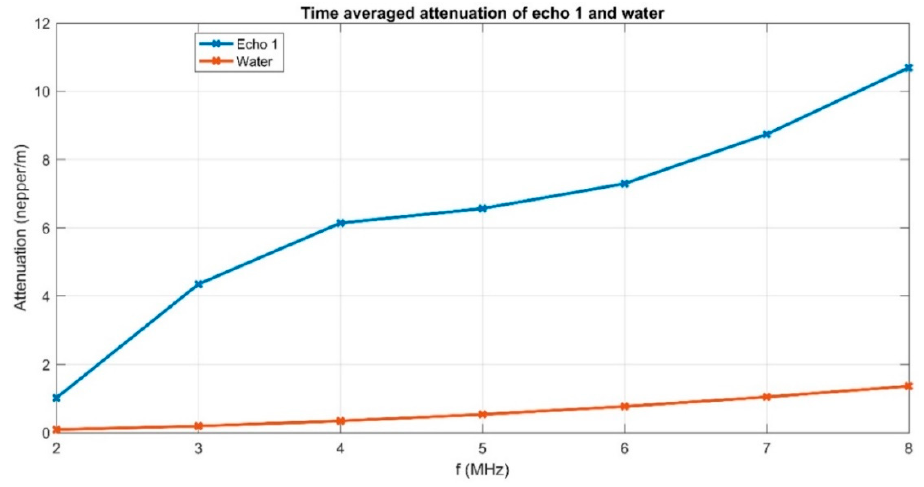
Figure 5. Attenuation vs. frequency for the first transmitted echo.